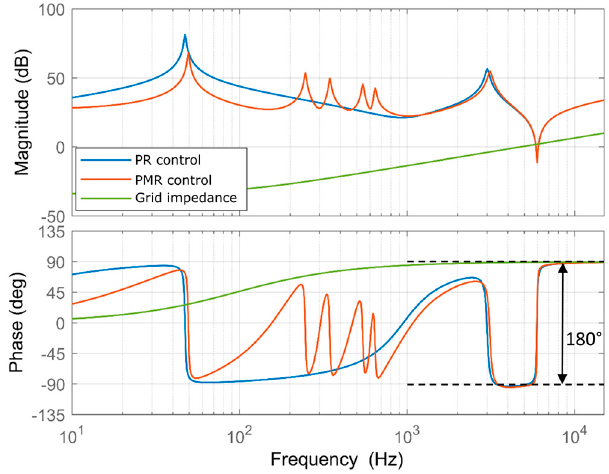
Figure 11. Bode plot of the inverters impedance Z inv ( s ) with PR and PMR controllers.